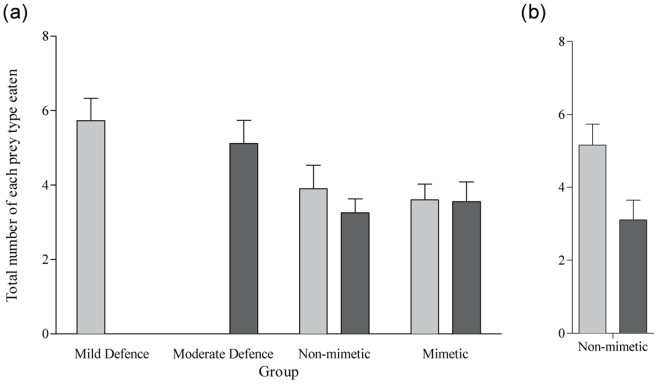
The mean (+ SE) number of mildly defended prey (light grey bars) and moderately defended prey (dark grey bars) eaten per session when birds had reached asymptote (sessions 3–8).In (a) data for all birds in all groups is included, and in (b) only data for the six discriminating birds in the Non-mimetic group is included (see text for details). Values that were significantly lower in the Non-Mimetic group compared to the Mild Defence and Moderate Defence group are marked with an asterisk. (N = 10 for all groups except the Non-Mimetic group where N = 9 in (a) and N = 6 in (b)).